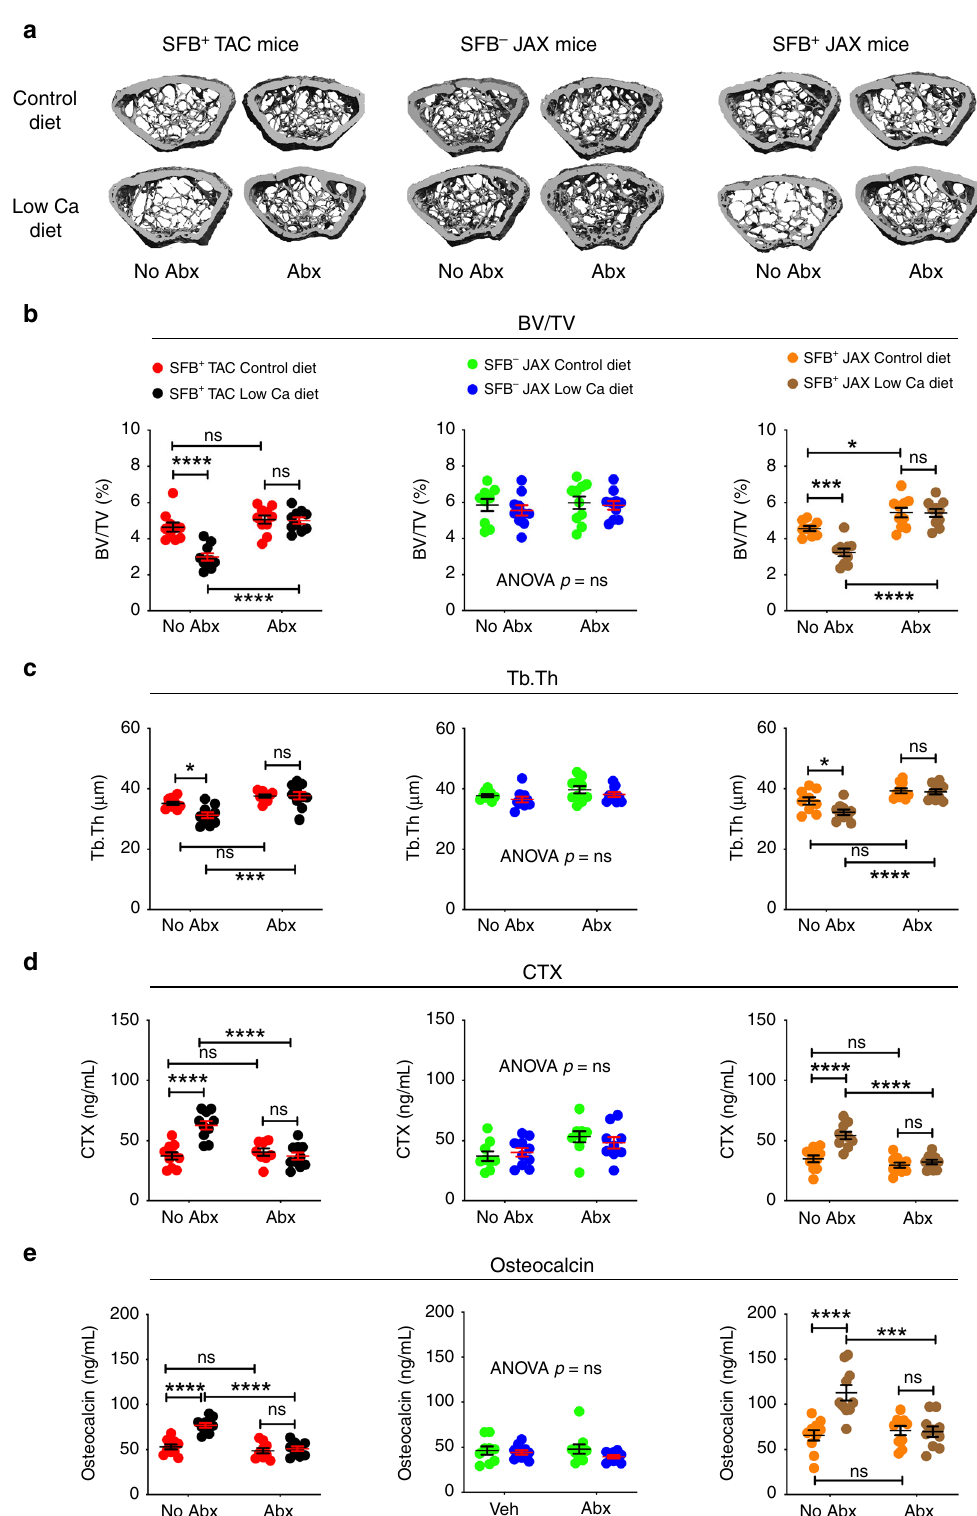
Fig. 2 SFB + microbiota is suf fi cient for low calcium diet to induce trabecular bone loss and stimulate bone turnover. SFB + TAC and JAX mice and SFB - JAX mice were treated with control diet or low calcium diet for 4 weeks and with antibiotics (Abx) or without antibiotics (No Abx). a The fi gure shows images of representative three-dimensional μ CT reconstructions of examined femurs. b Femoral trabecular bone volume/total volume fraction (BV/TV), n = 9 – 10 mice per group. c Trabecular thickness (Tb.Th), n = 9 – 10 mice per group. d Serum levels of CTX, a marker of bone resorption, n = 8 – 10 mice per group. e Serum levels of osteocalcin, a marker of bone formation, n = 9 – 10 mice per group. All data are expressed as Mean ± SEM. All data were normally distributed according to the Shapiro-Wilk normality test. Data were analyzed by two-way ANOVA and post hoc tests applying the Bonferroni correction for multiple comparisons. * p < 0.05, *** p < 0.001, and **** p < 0.0001 compared to the indicated group. Source data are provided as a Source Data fi